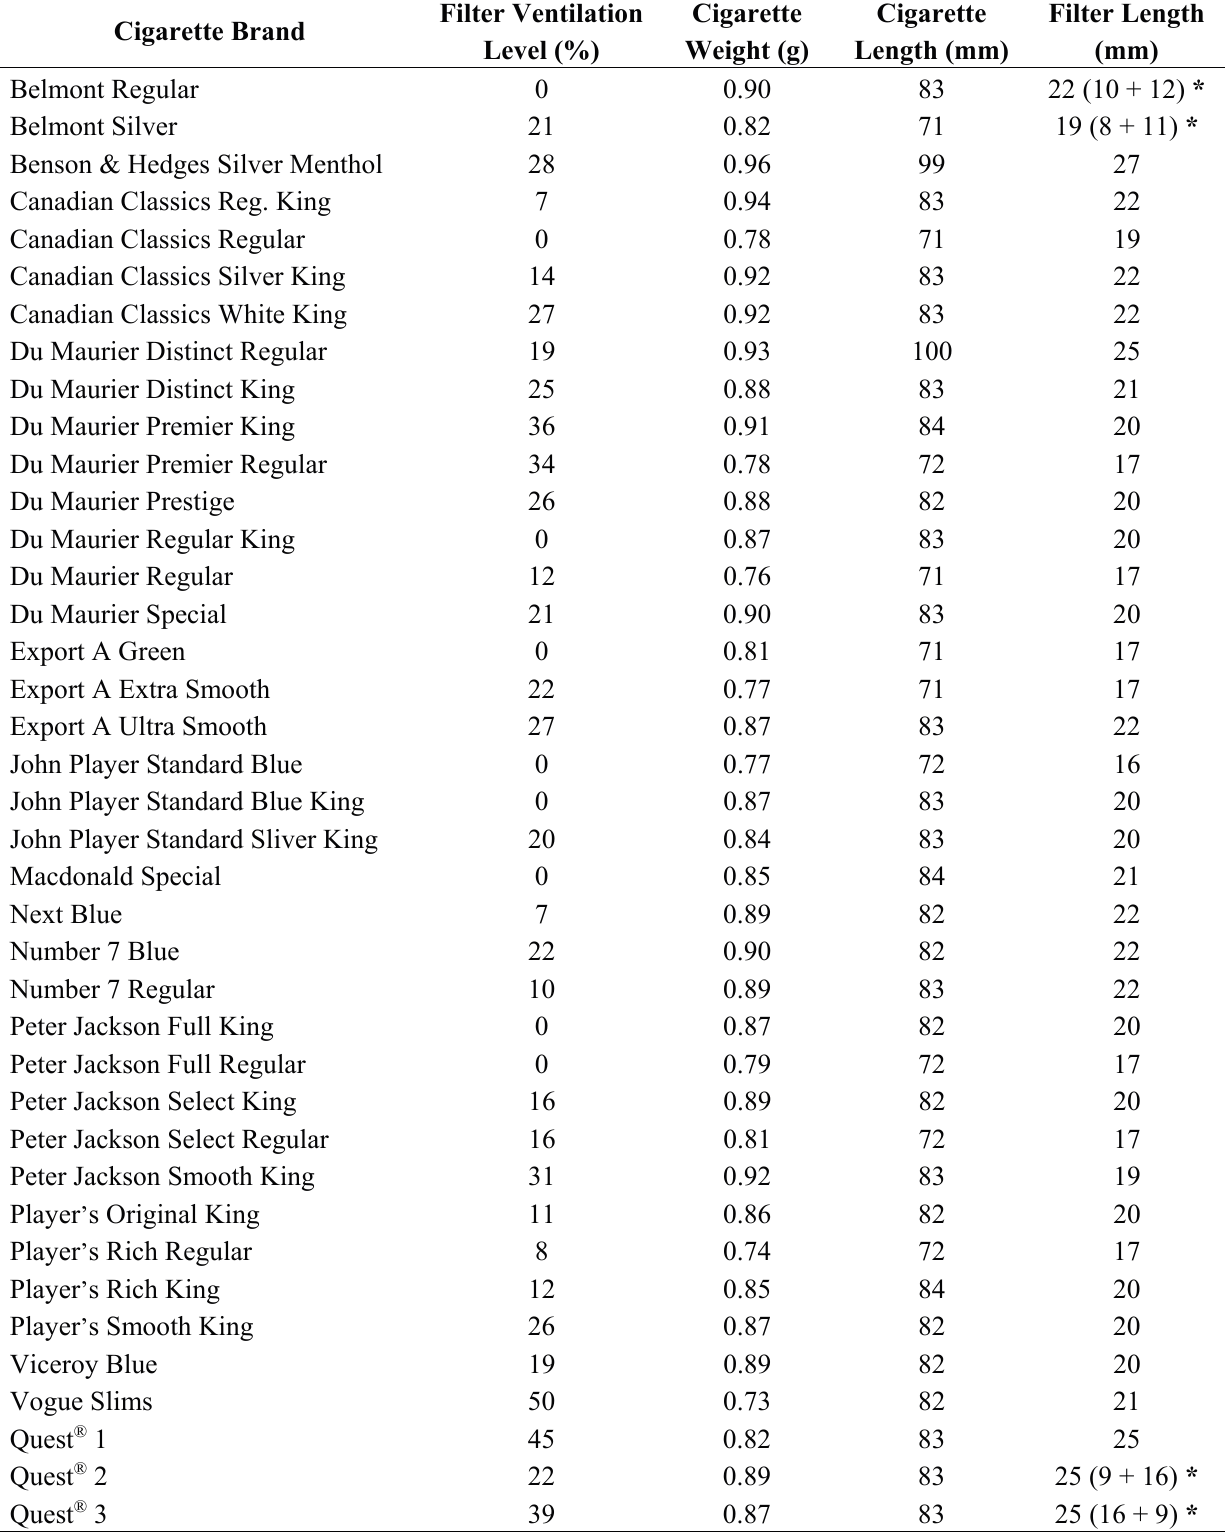
Table 2. Cigarette physical properties of all participants’ usual brands and the Quest ® brands. Cigarette Brand